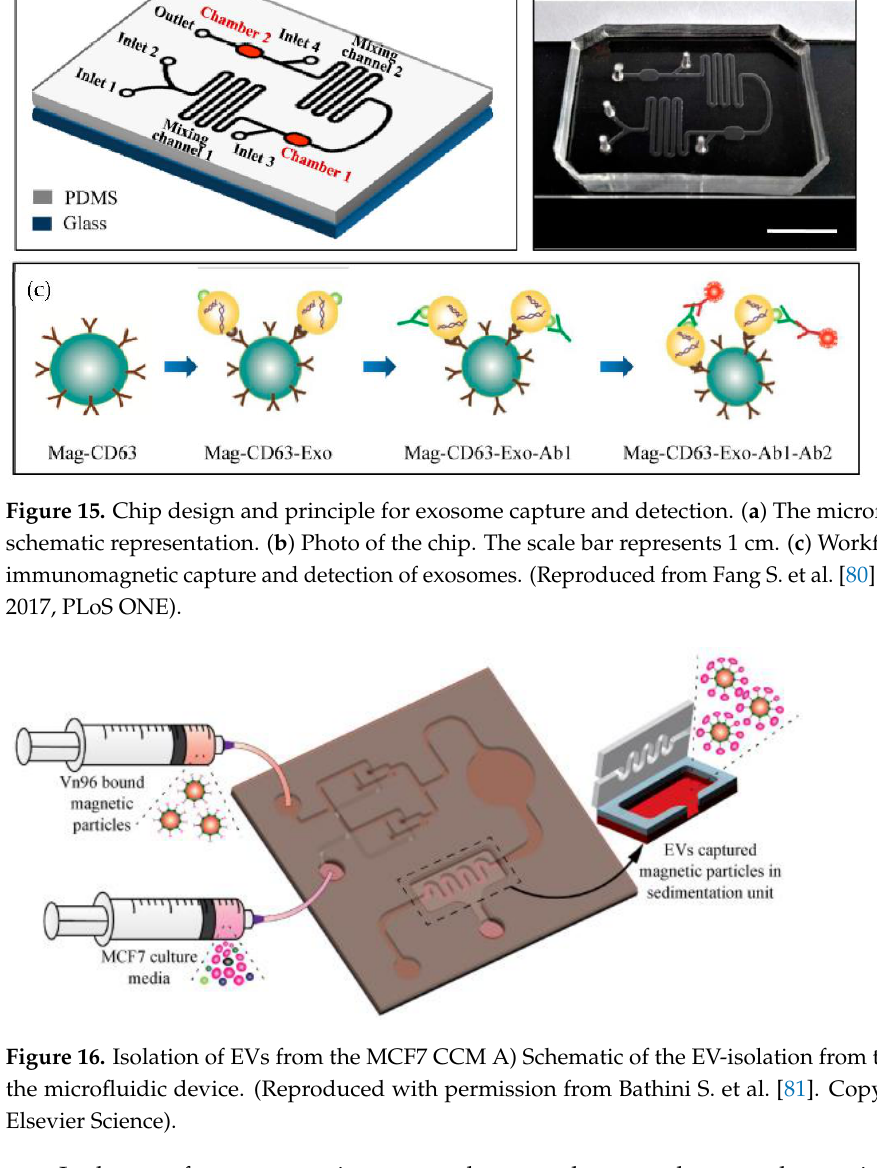
Figure 16. Isolation of EVs from the MCF7 CCM A) Schematic of the EV-isolation from the CCM in the microfluidic device. (Reproduced with permission from Bathini S. et al. [81]. Copyright 2021, Elsevier Science).